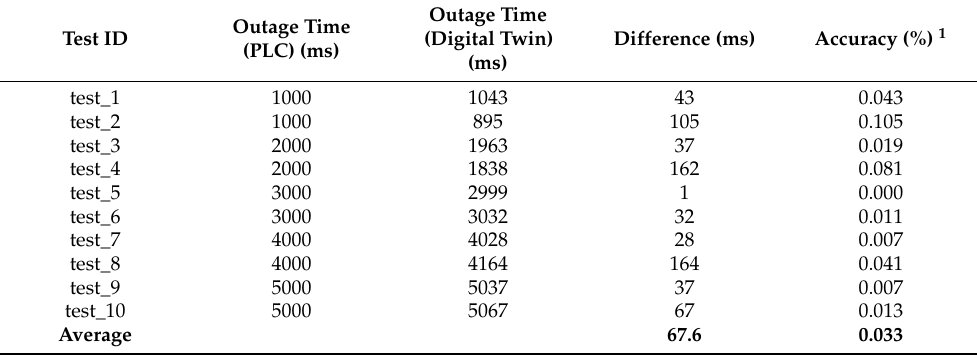
Table 2. Measurement data for determining the stoppage time of the